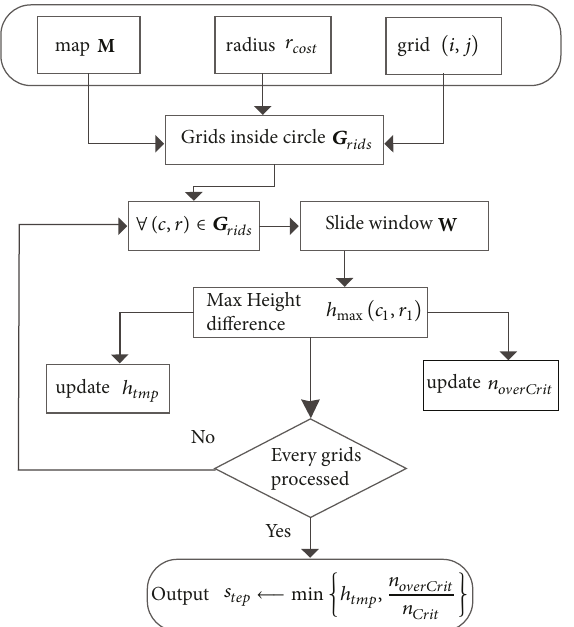
Figure 2: The processing diagram for computing the step